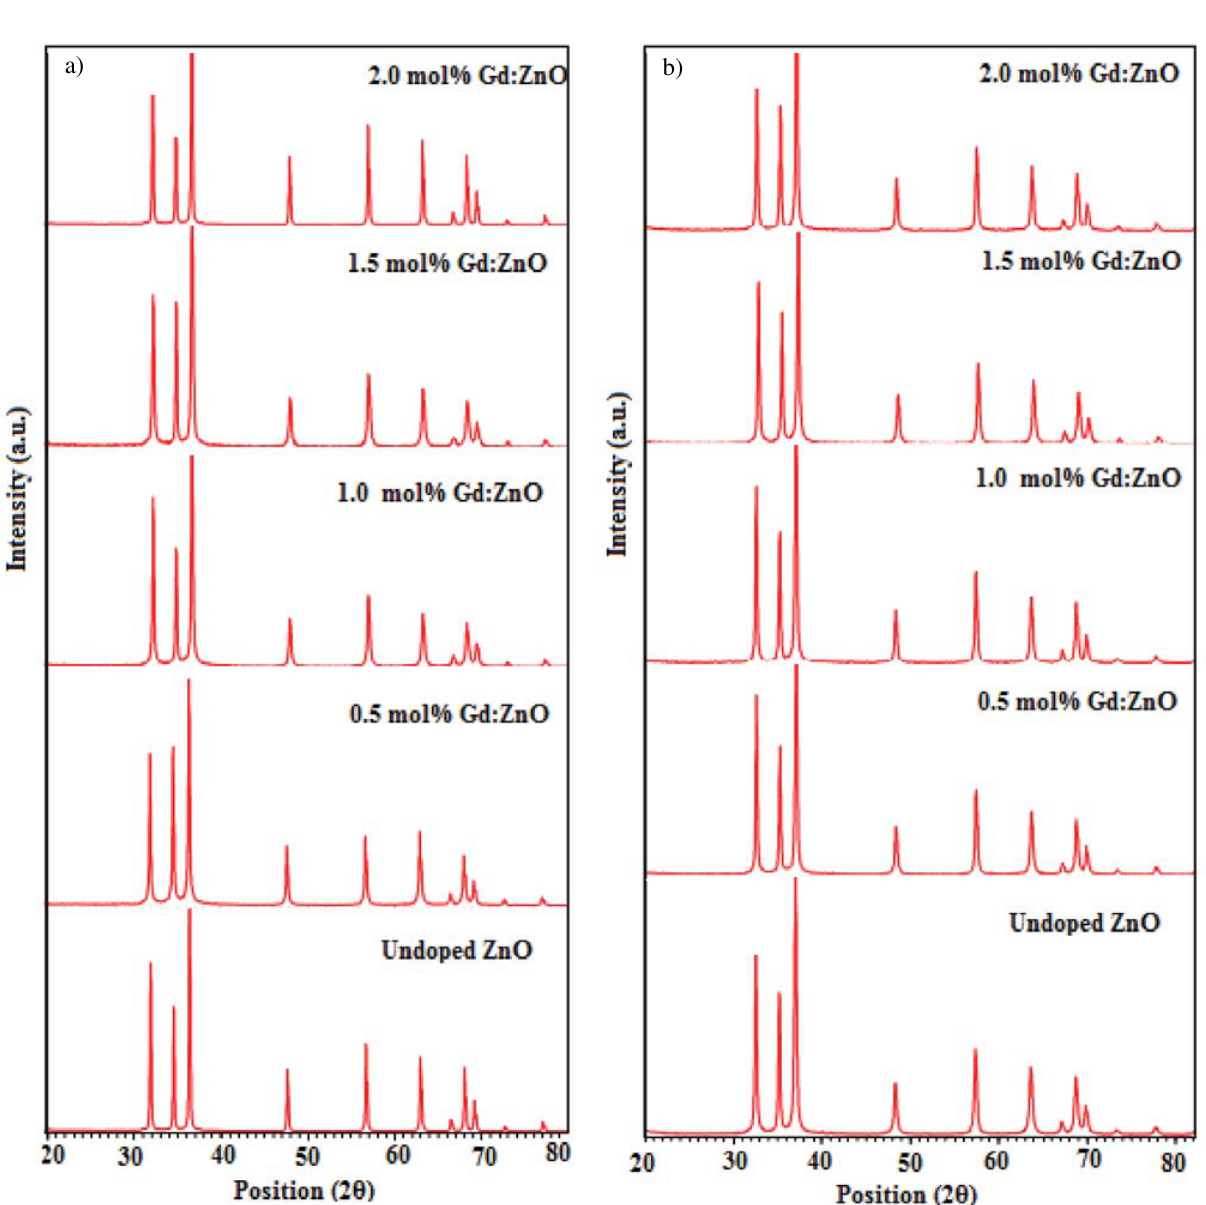
Figure 3. PXRD pattern of undoped and Gd doped ZnO nanoparticles synthesized using (a) CTAB and (b)